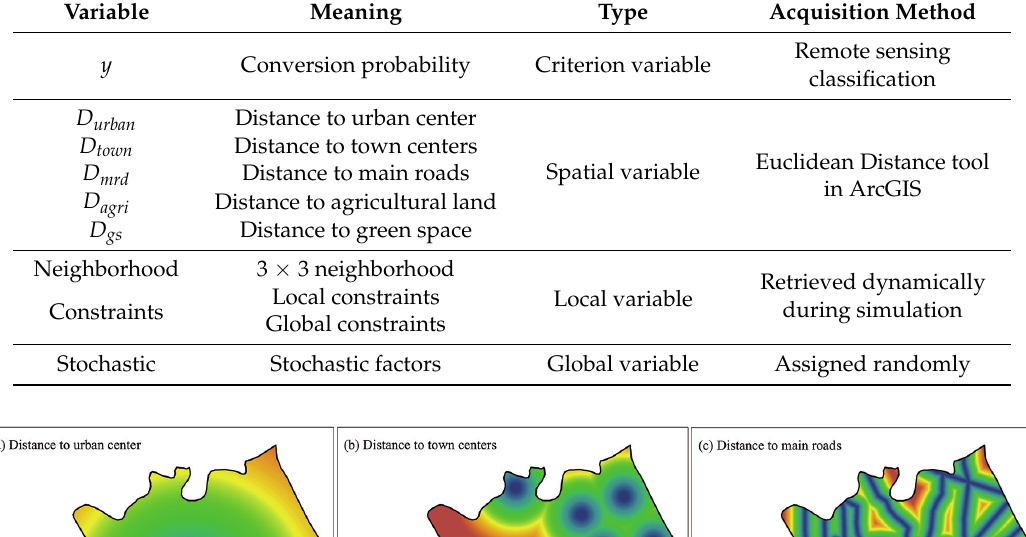
Table 1. The spatial variables used to simulate urban growth in the partial least squares-based cellular automata (PLS-CA) model.